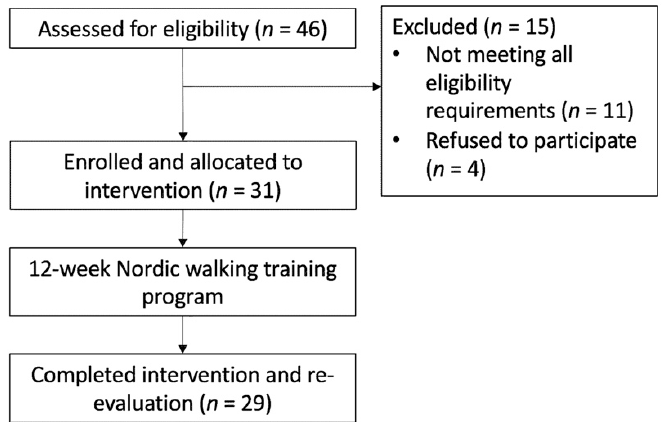
Figure 1. Flow diagram of participant recruitment and retention.